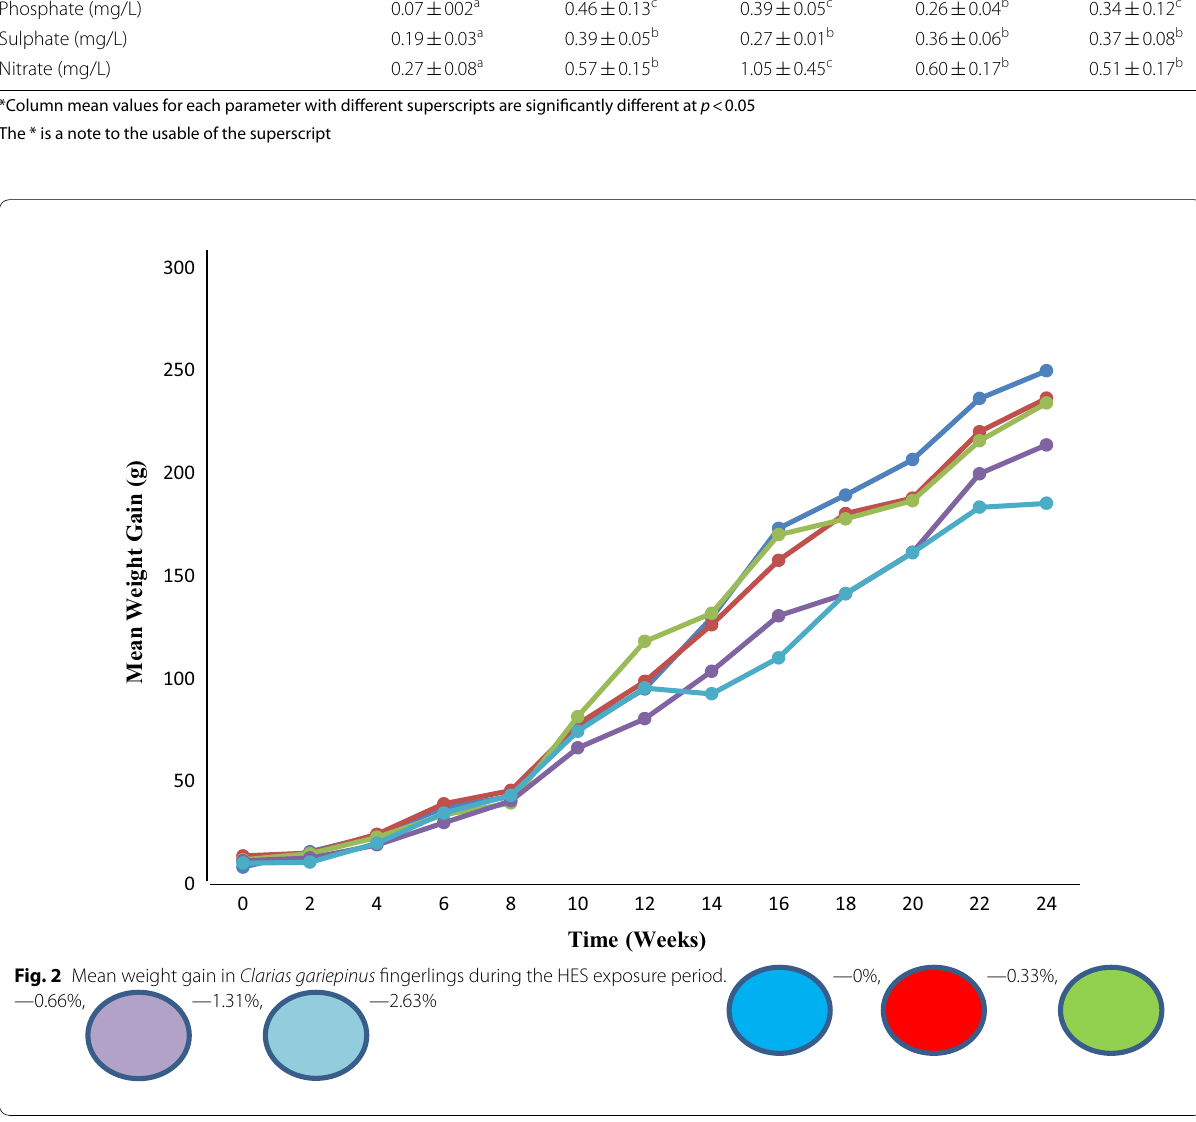
Fig. 2 Mean weight gain in Clarias gariepinus fingerlings during the HES exposure